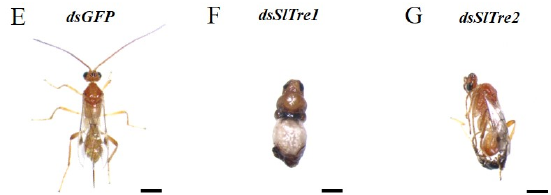
Figure 8. The emergence rate, proportion, and morphology of abnormal adults of parasitic wasp